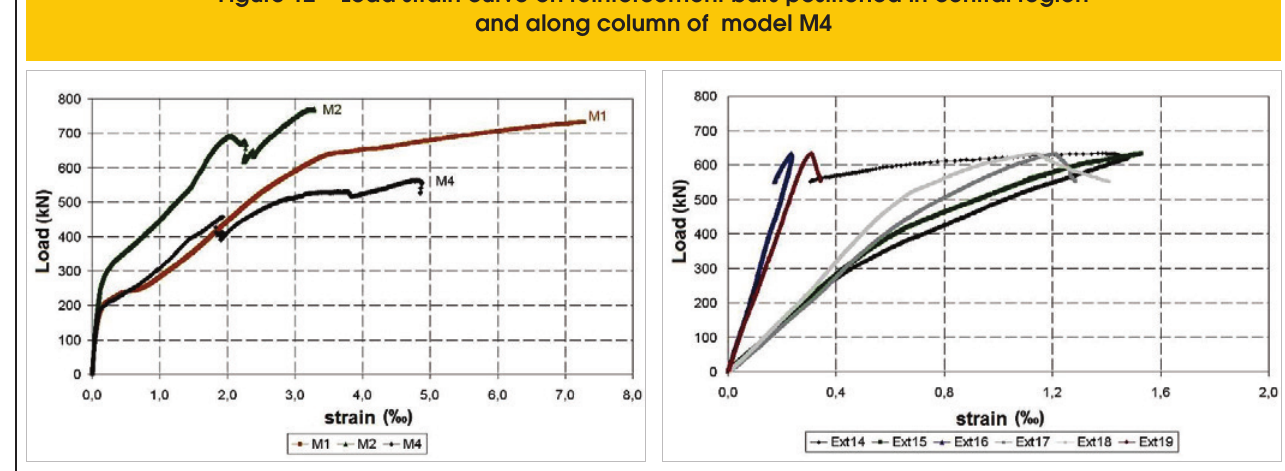
Figure 12 – Load-strain curve on reinforcement bars positioned in central region and along column of model